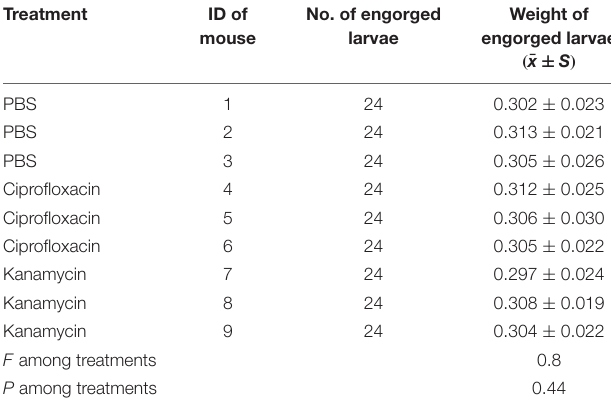
TABLE 4 | Weights of engorged larvae gathered from different mice (micrograms). Treatment